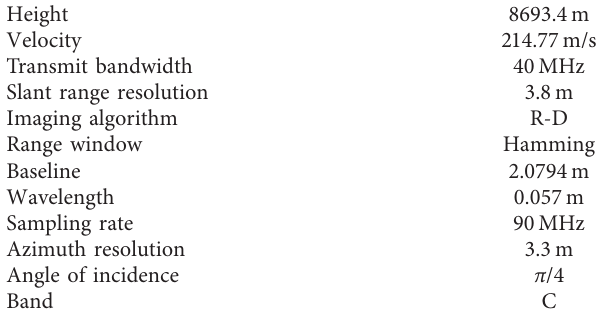
Table 1: Simulation parameters for ATI